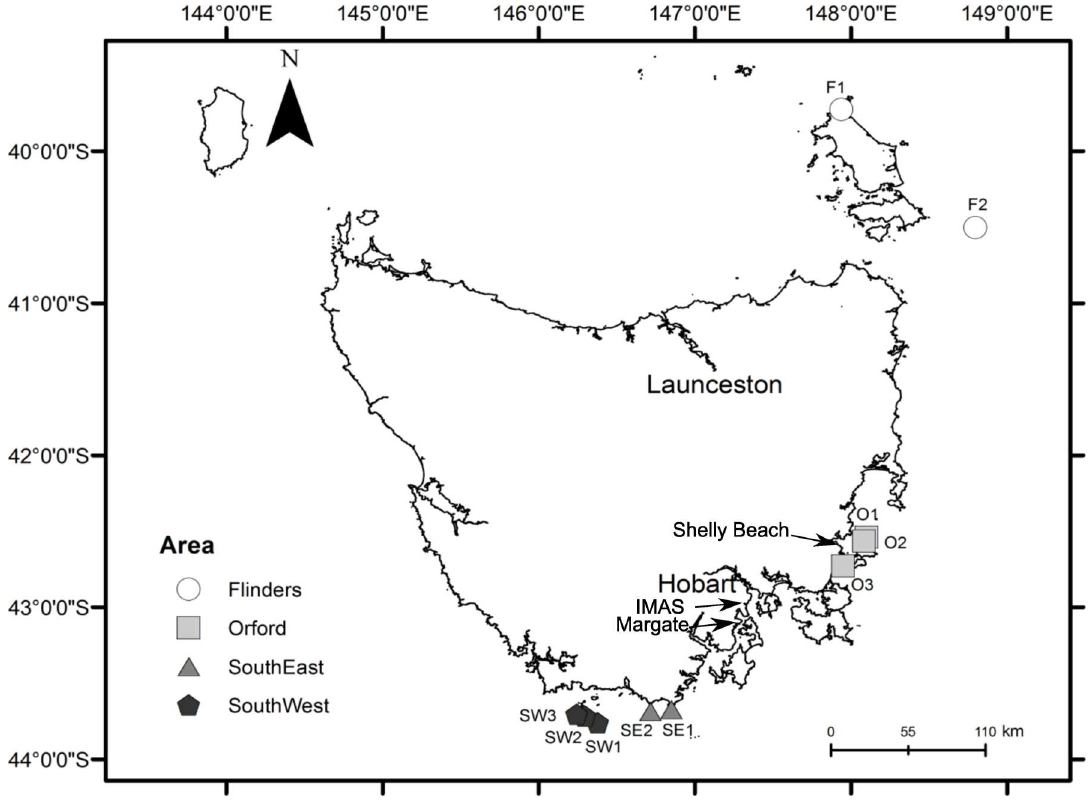
Fig 1. Map of sampling sites at four different sampling areas (Flinders, Orford, South East and South West) and sites (F1, F2, O1, O2, O3, SE1, SE2, SW1, SW2, and SW3) around Tasmania.